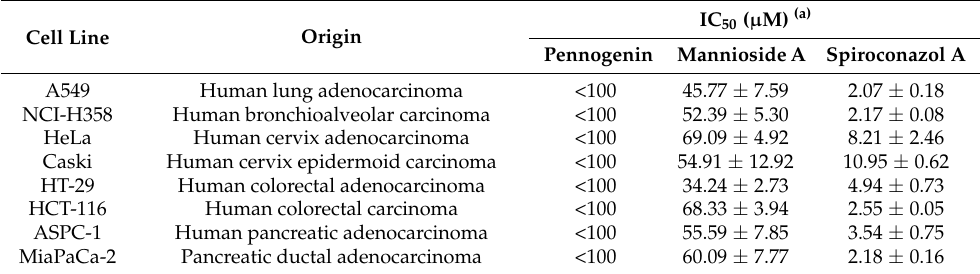
Table 1. Cytotoxic effect of the steroidal saponins on various cancer cells.